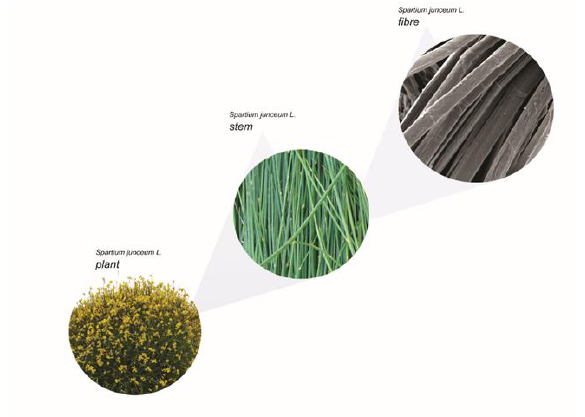
Figure 1. Representation of SJL plant and its structural above ground axis, which is raw material for fibre production; Left to right: SJL shrub during bloom; Freshly harvested SJL stem; Scanning electron micrograph of